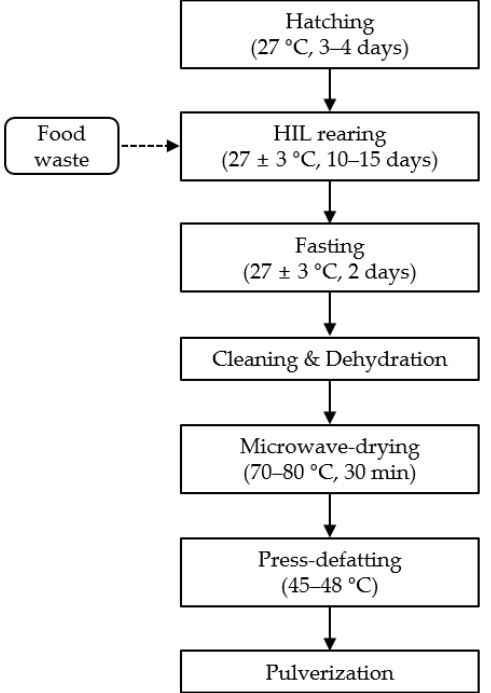
Figure 1. Schematic presentation of manufacturing of Hermetia illucens larvae meal (HILM).